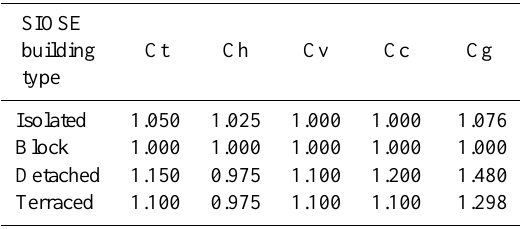
Table 6. Coefficient of increase in building’s value